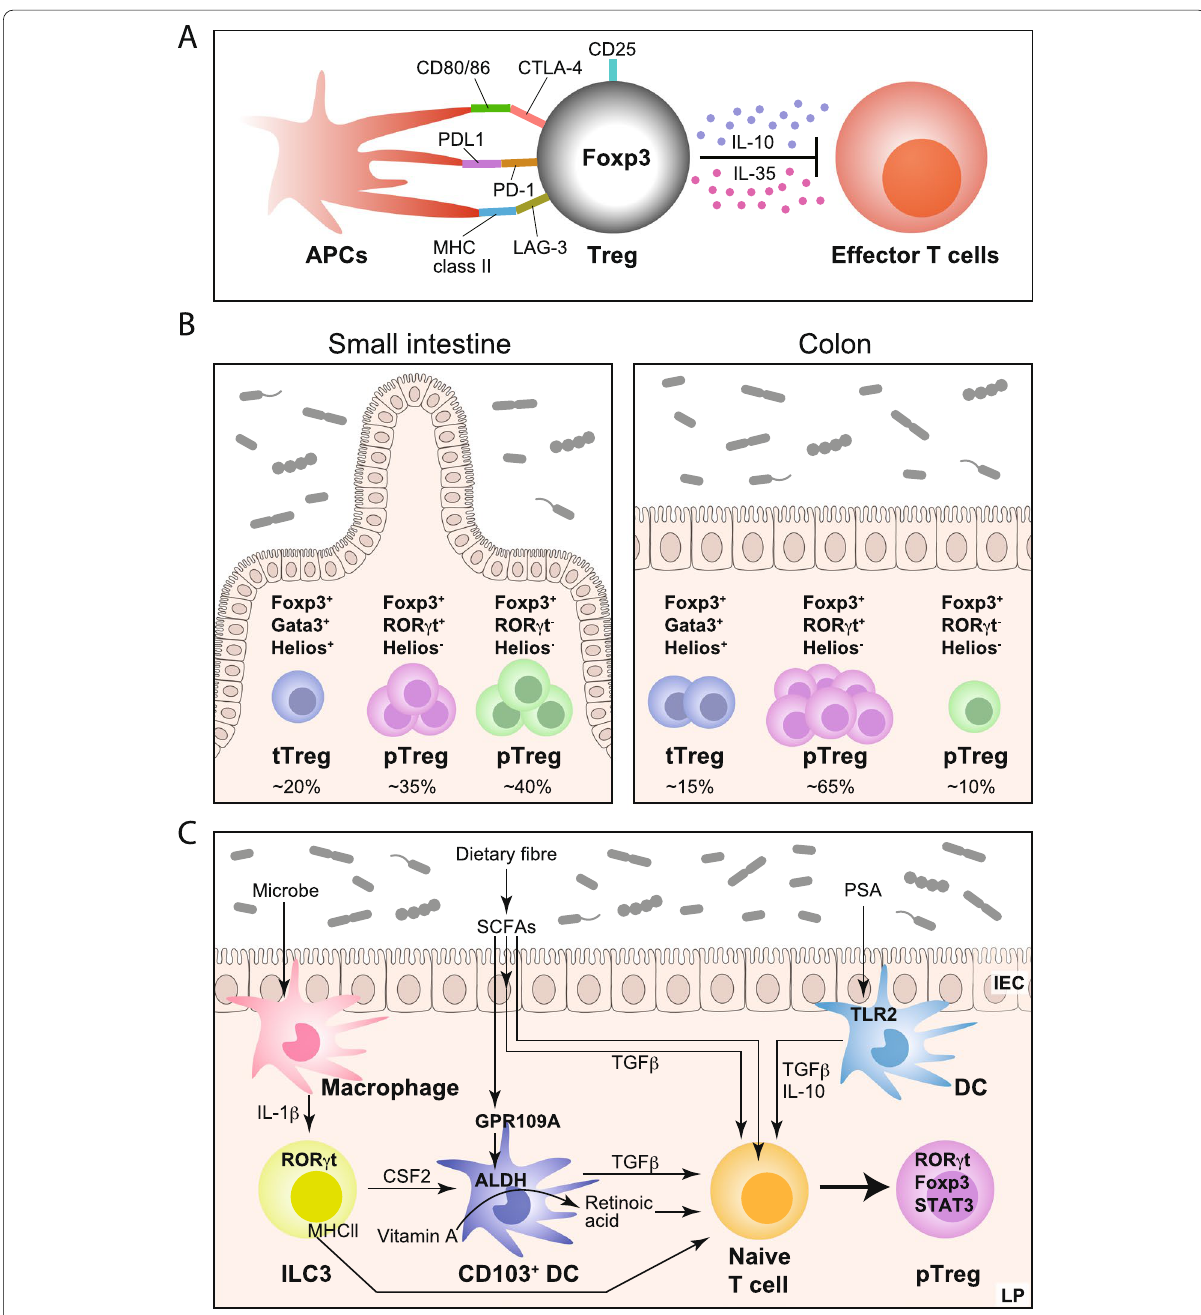
Fig. 1 Characteristics of Treg in gut. A Tregs suppress effector cells and antigen-presenting cells via surface protein and cytokine. B Helios + Gata3 + Foxp3 + Tregs (thymic Tregs: tTregs), Helios − Rorγt + Foxp3 + Tregs (peripheral Tregs: pTregs), Helios − Rorγt − Foxp3 + Tregs (peripheral Tregs: pTregs) in small intestine (left) and colon (right). The percentage of each population in total Tregs was listed below. C Schema of generation of peripheral Tregs in